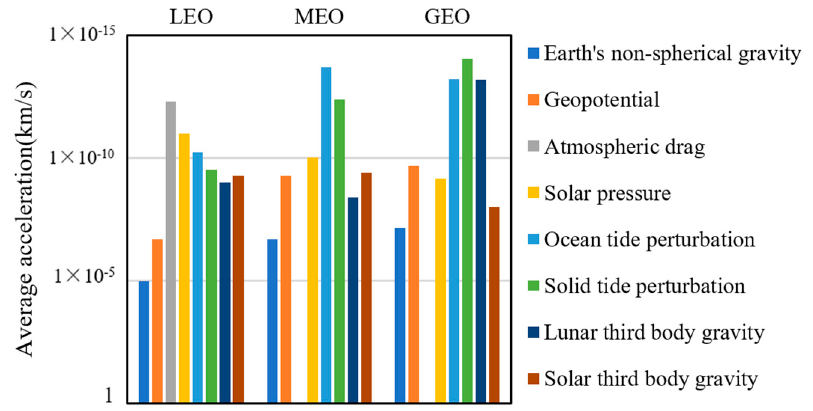
Figure 2. The magnitude of the perturbation force on satellites in different orbits .